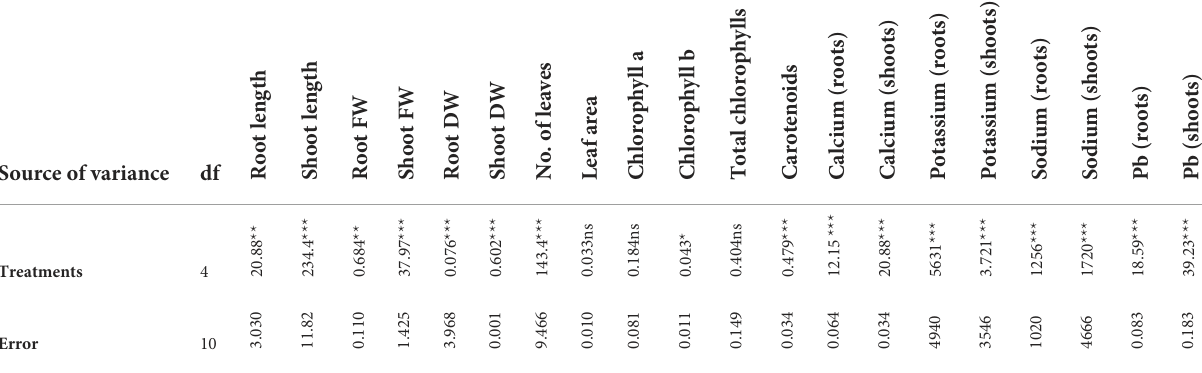
TABLE 2 ANOVA of various attributes of P. hysterophorus in response to Set-1 of treatments.